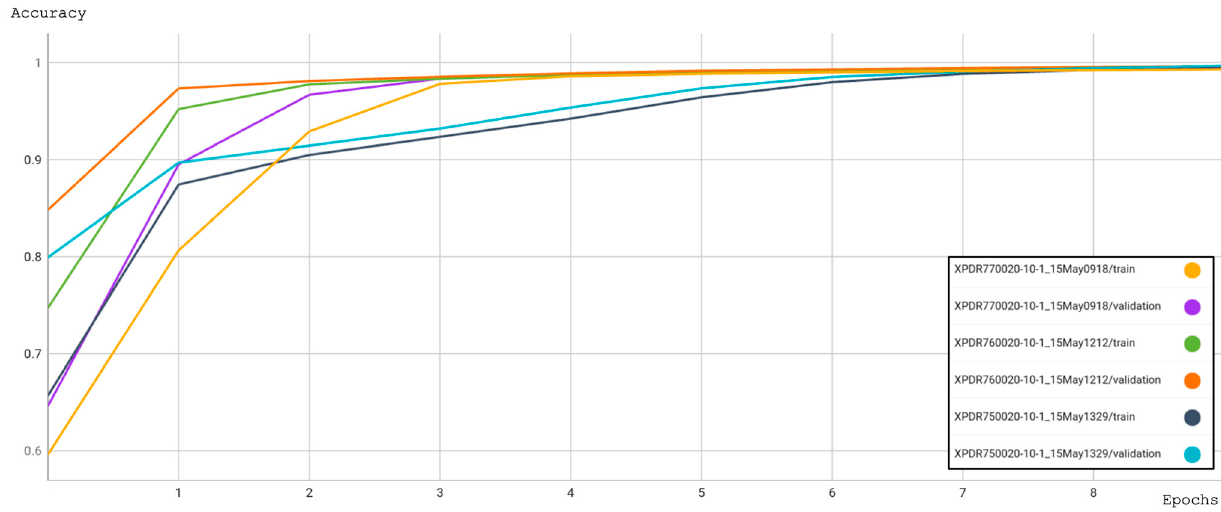
Figure 12. Emergency situations: model accuracy.